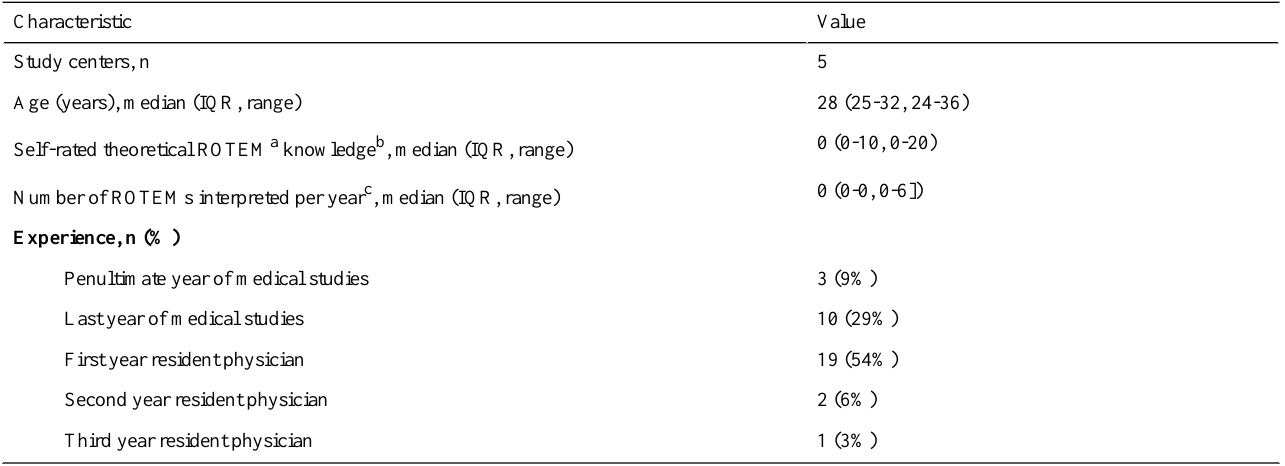
Table 1. Study and participant characteristics (N=35).